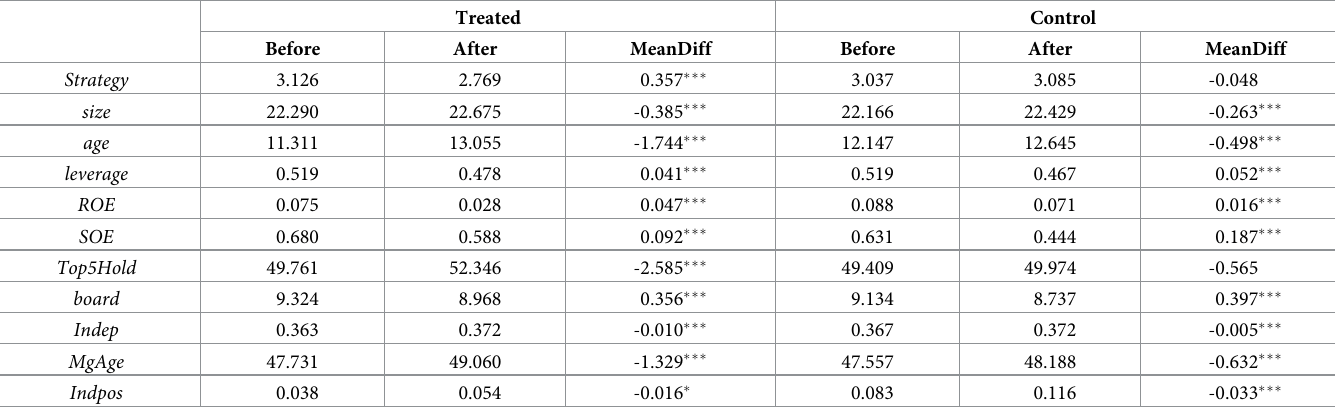
Table 3. Two-group testing of the difference of the